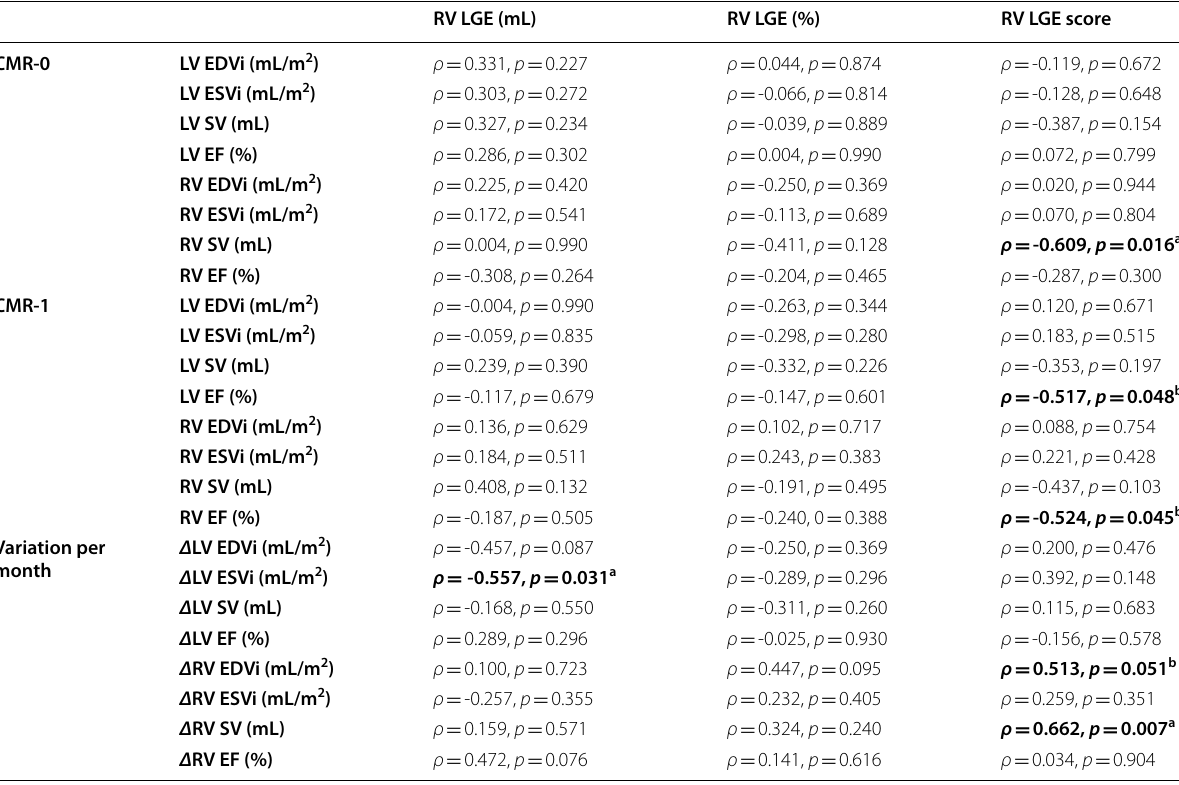
Table 3 Correlations between extent, percentage, and score of right ventricular (RV) late gadolinium enhancement (LGE) and functional